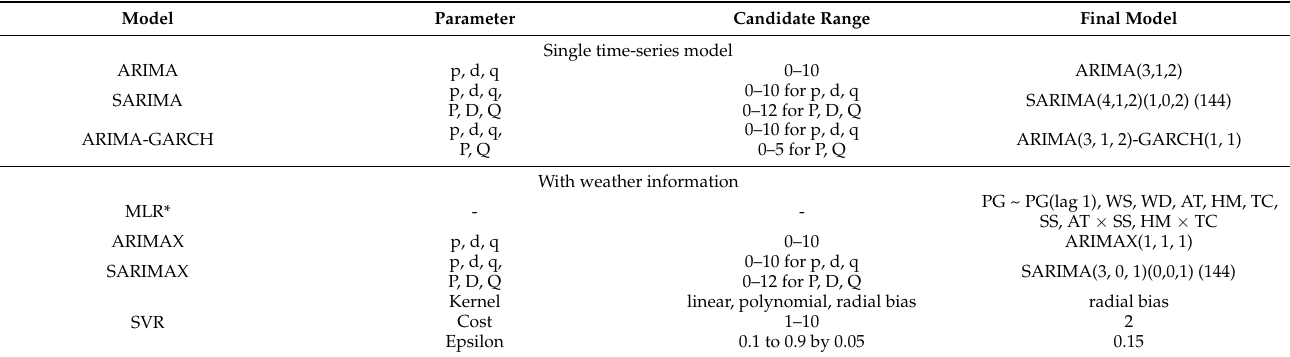
Table 2. Range of parameters for grid search and the final model in model optimisation.